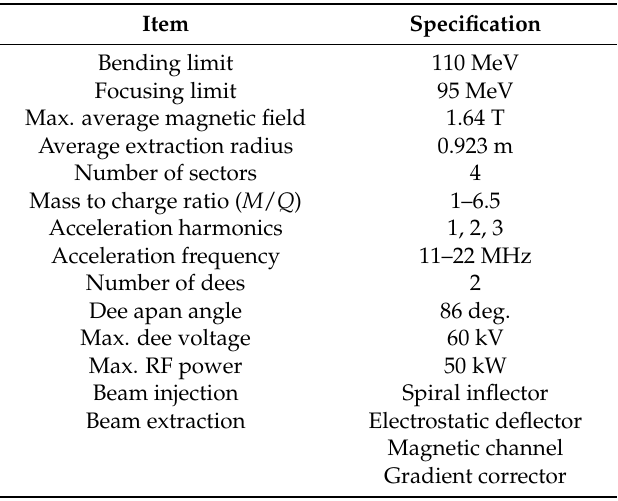
Table 2. List of the electron cyclotron resonance (ECR) ion sources.